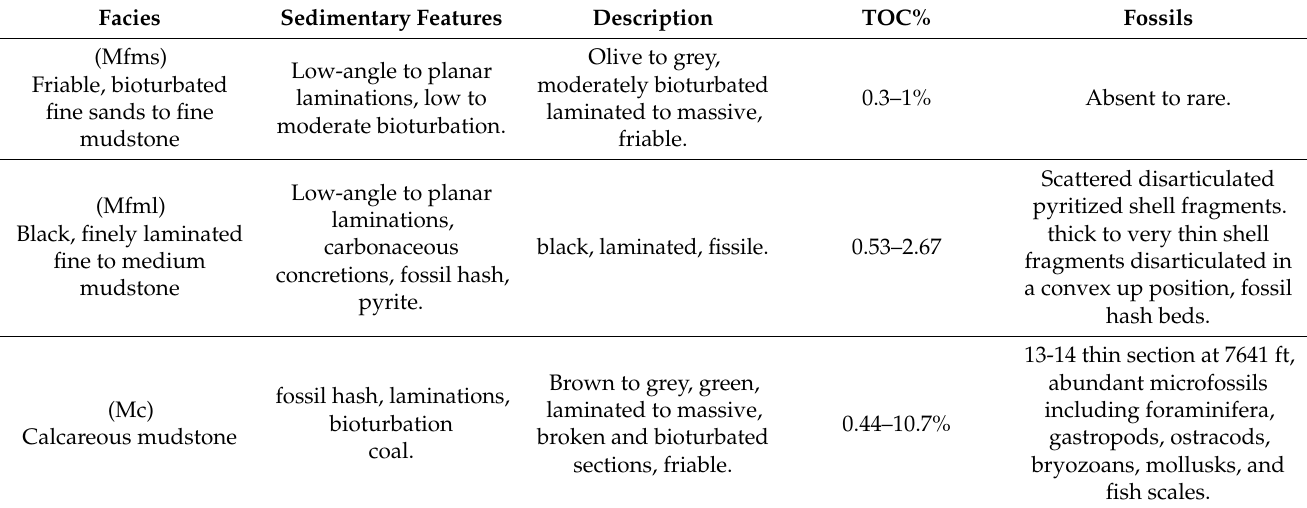
Table 2. Morrow shale lithofacies. Total organic carbon (TOC) data from TerraTek Schlumberger core services.